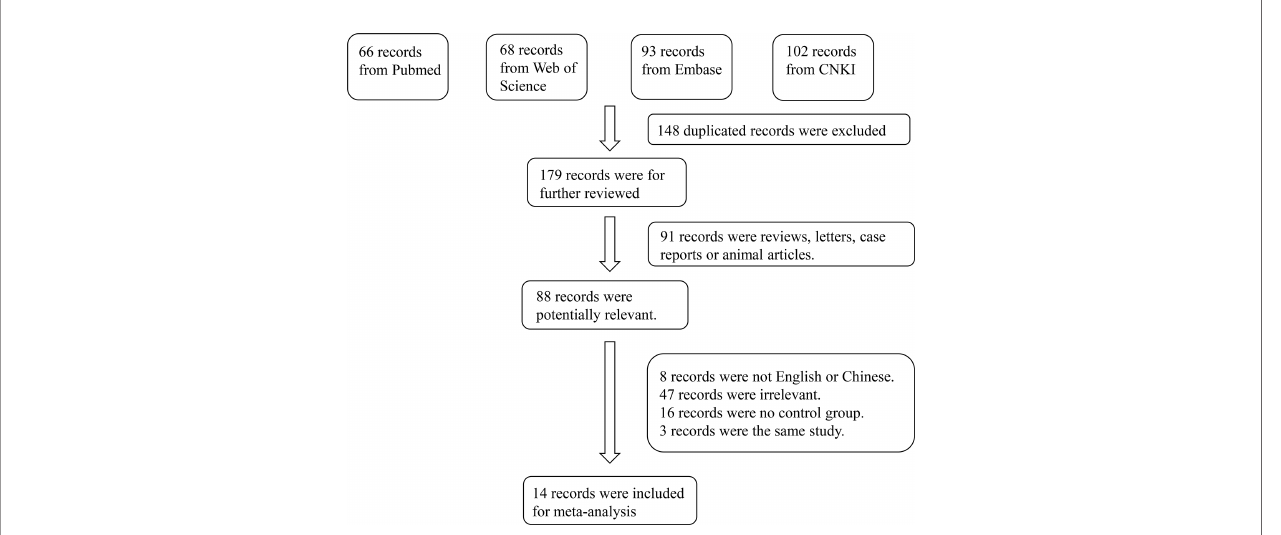
FIGURE 1 | Flowchart of the detailed procedure for the inclusion or exclusion of selected